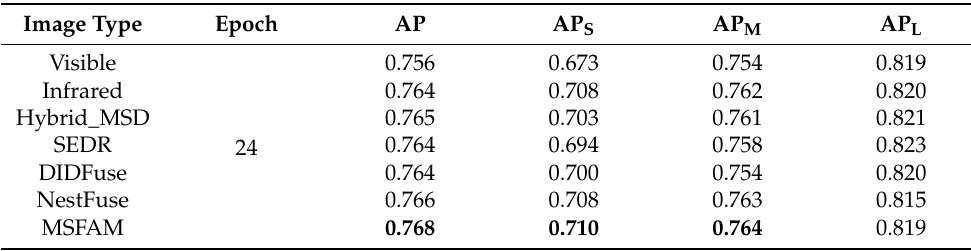
Table 7. GFLV2 evaluation result of different types of images on the KAIST Multispectral Pedestrian Detection Benchmark. Bold represents for the best result in